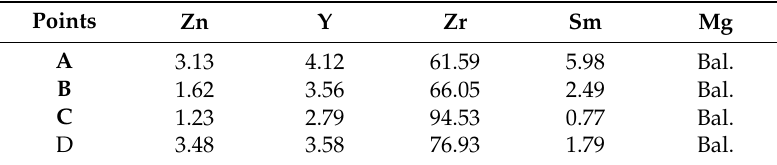
Table 3. EDS results corresponding to the selected points in Figure 8 (wt %).